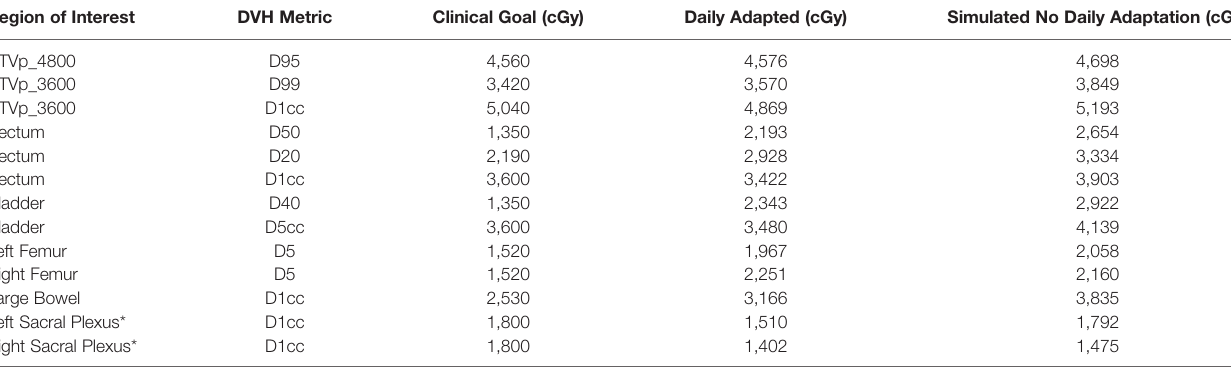
TABLE 1 | Comparison of key dose volume histogram (DVH) metrics between daily adapted and simulated work fl ow with single mid-treatment adaptation. Region of Interest Clinical Goal (cGy) Daily Adapted